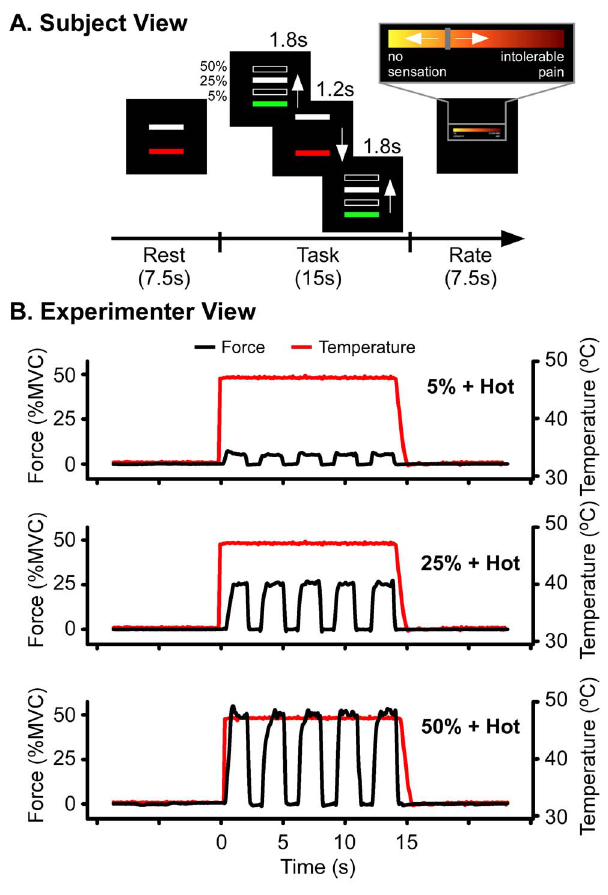
Figure 1. Experimental paradigm. A. The white bar represented the target force level which was set at the beginning of each trial to 5%, 25%, or 50% of each subjects’ MVC. A second red/green force bar was controlled by the subject and provided real-time visual feedback of their force production during active conditions, or moved according to a pre-recorded force trace during passive conditions. The bar was red during rest periods and green when the subject had to produce force or view the pre-recorded force trace. When the force bar turned green, the subject’s goal was to match the green bar with the white bar. Each trial was 15s long, and included 5 force pulses. Each pulse was 1.8s (bar turns green) and pulses were separated by a 1.2s rest period (bar turns red). Trial timing was the same during passive conditions but subjects were instructed to view the green bar and not produce any force. The pre-recorded force trace was collected during each participant’s practice session. Each 15s trial was followed by a 7.5s rating period. Subjects rated the level of stimulation they experienced during the previous 15s trial. Ratings were made using a button box to control a cursor on a visual analog scale (VAS) presented on the screen. B